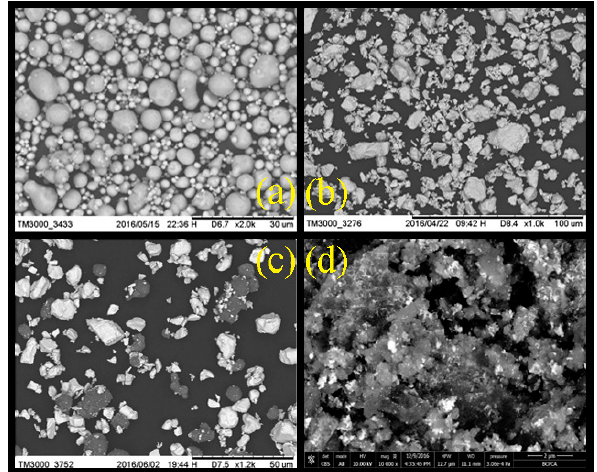
Figure 2. SEM image of sample morphology: ( a ) Al; ( b ) Bi 2 O 3 ; ( c ) physical mixing of Bi 2 O 3 and Al; and ( d ) samples after two-step milling.